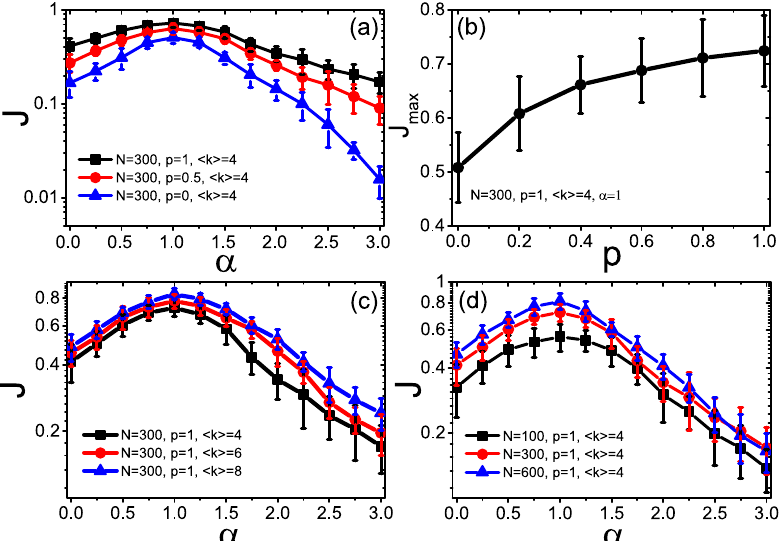
Figure 2. Influence of the controlling parameter α and network structure on the total flux J , with averaging over 50 realizations and randomly chosen source nodes. ( a ) J versus α for N = 300 , � k � = 4 and different p , where the “squares”, “circles” and “triangles” represent the results for the networks with p = 1, 0.5 and 0, respectively. ( b ) Dependence of the maximum flux J max on the parameter p for α = 1 . ( c ) J versus α for N = 300 , p = 1 for different (cid:31) k (cid:30) , where the “squares”, “circles” and “triangles’ represent the results for � k � = 4, 6 and 8, respectively. ( d ) J versus α for p = 1 , � k � = 4 for different N , where the “squares”, “circles” and “triangles” represent the results for N = 100, 300 and 600, respectively.